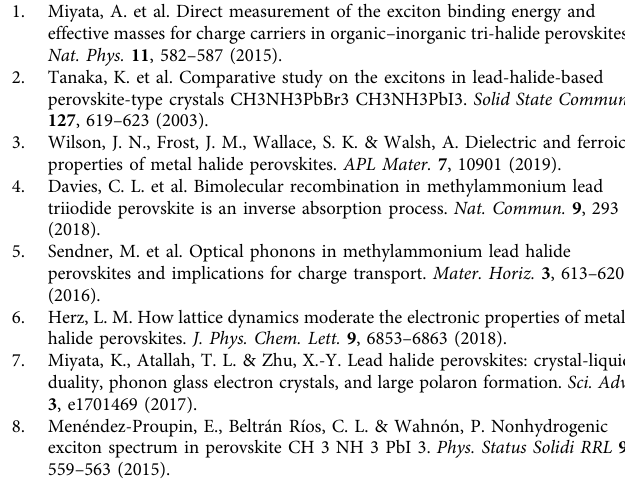
Fig. 4 Photo-induced carrier localization. a The carrier mobility ( μ s , open squares) obtained from the fi tted value of the momentum scattering time ( τ s ). μ avg is the carrier mobility calculated from the frequency-averaged photoconductivity (open circles). ratio of μ dc / μ s = 1 − ϕϕ b decreases with carrier density, indicating photo-induced carrier localization. Solid lines are exponential fi ts to the data of MA, FAMA and CsFAMA thin fi lms, respectively. c Comparison of τ s and ϕϕ b between ground-state and excited-state together with the ground-state exciton binding energy ( R b 0 ). The black arrows indicate photo-induced enhancement of electron-phonon coupling and lattice fl uctuations. All error bars indicate